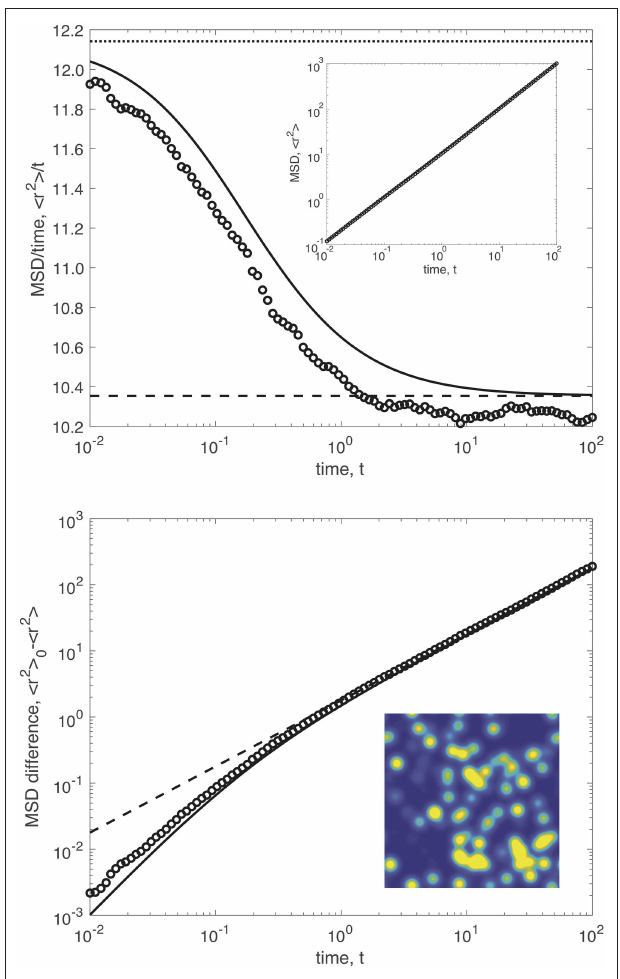
FIGURE 2 | The mean-square displacement (MSD) for particle diffusion in a heterogeneous environment. The top plot shows the ratio MSD / t curve) vs. time for heterogeneous diffusivity with δ and σ 1 / 2. The dotted curved indicates the short-time MSD = the dashed curve shows the long-time MSD simulations are shown as dots. The inset plot shows the MSD before dividing by time. The bottom plot shows the MSD difference inset image shows a realization of the diffusivity with color scaling from blue ( D 1) to yellow ( D = =